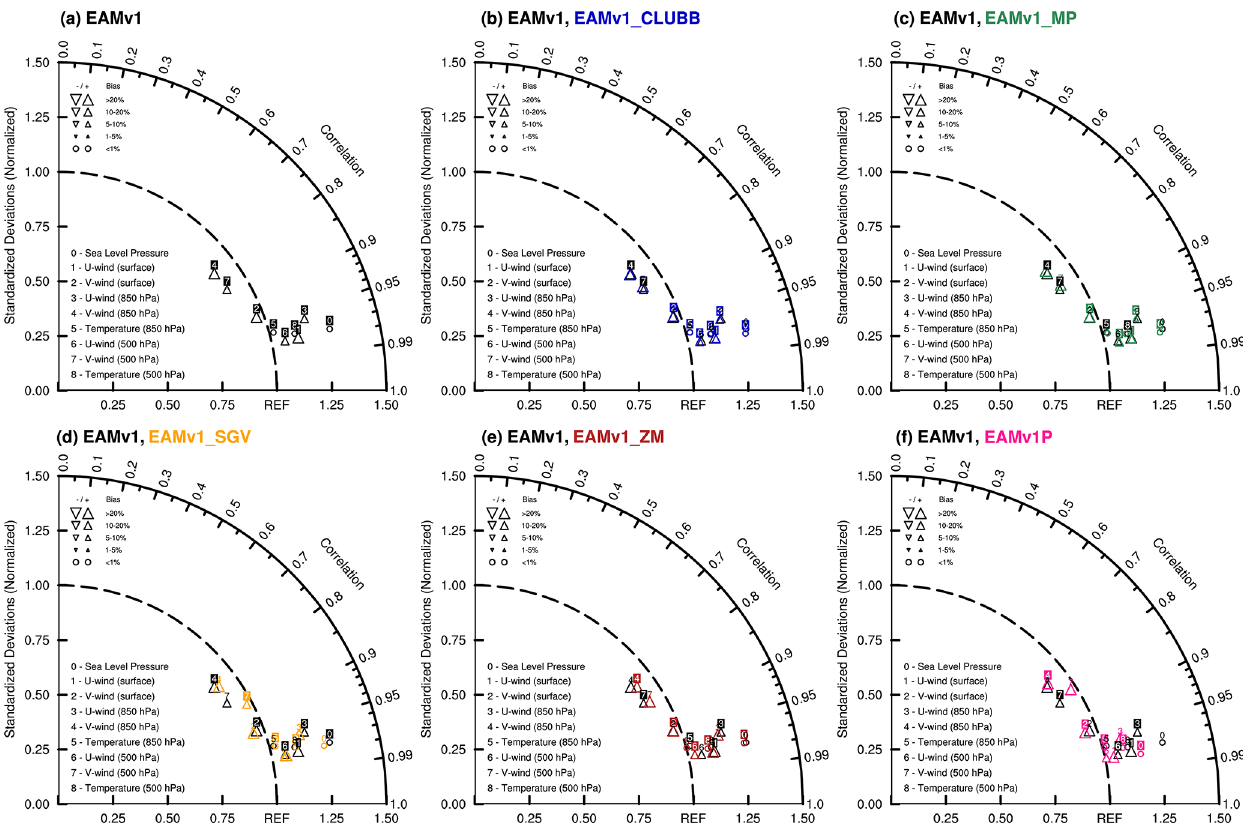
Figure 13. Taylor diagram (Taylor, 2001) comparing sea level pressure, temperature, and winds in EAMv1, EAMv1_CLUBB, EAMv1_MP,